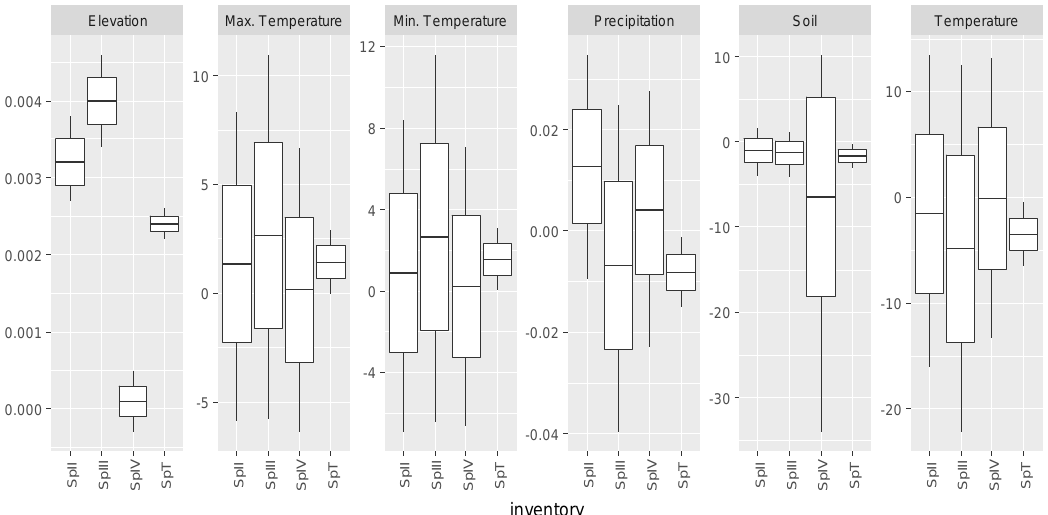
Figure 10. Boxplot diagram for posterior estimates of the covariates for Q. robur models: Spatial model II inventory (SpII); Spatial model III inventory (SpIII); Spatial model IV inventory (SpIV); Spatio-temporal model (SpT).